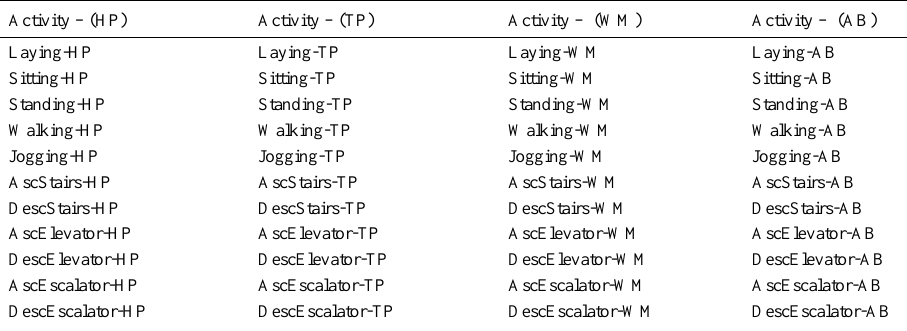
Table 2. List of activities for four different smartphone